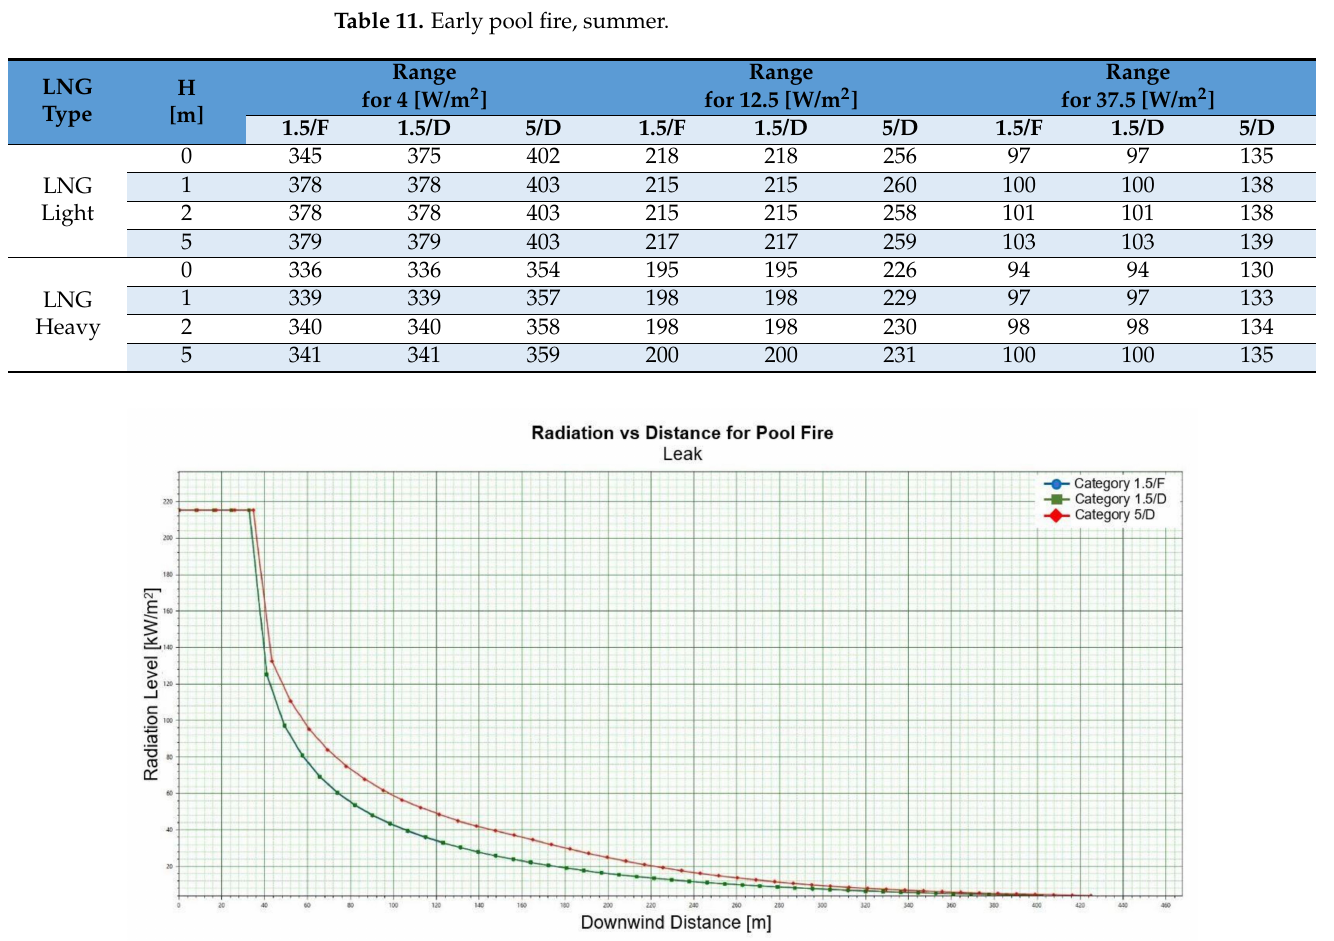
Figure 6. Early pool fire, radiation vs. distance, LNG-Light, 2 m,